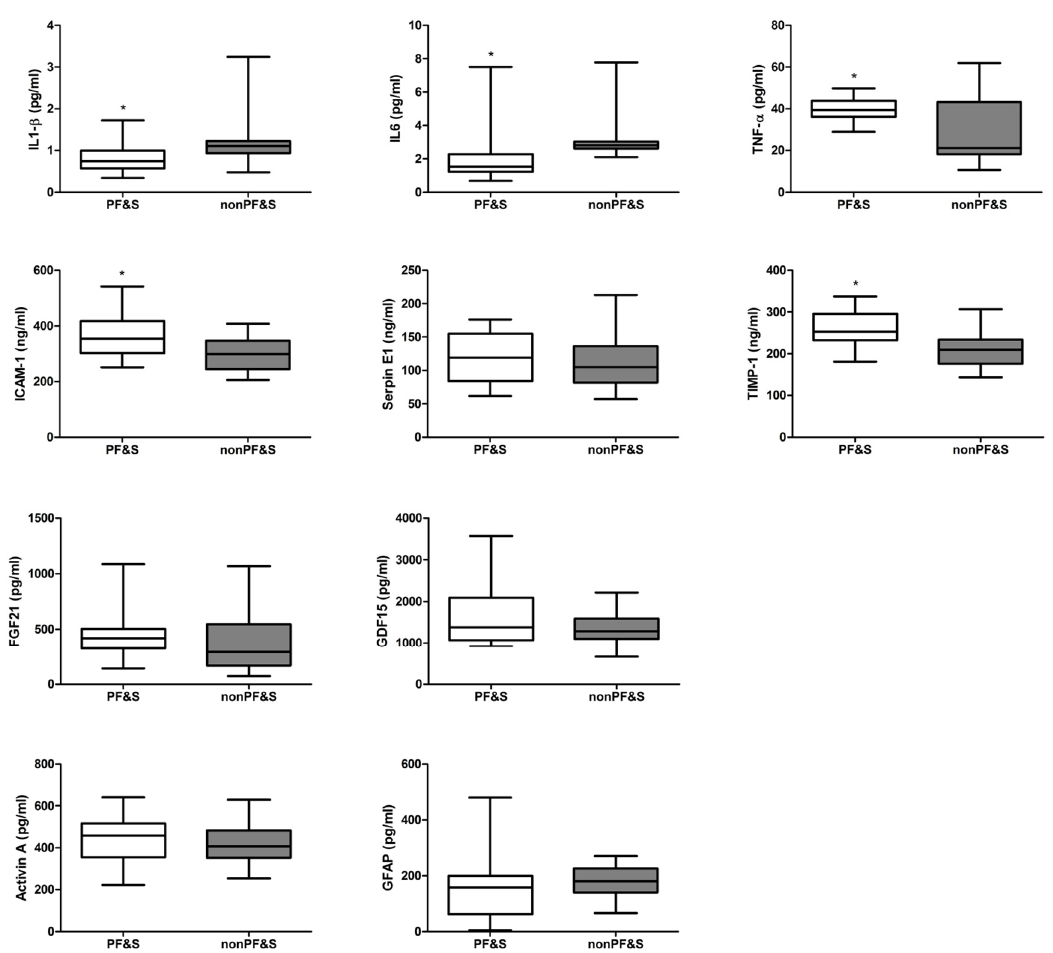
Figure 1. Serum Concentrations of Inflammatory, Mitochondrial, and Senescence-Related Markers in Participants with and without Physical Frailty and Sarcopenia (PF&S). Box plots show the median serum concentration (bold horizontal line), interquartile range (box), and total range of concentrations (whiskers) of markers. Abbreviations: FGF21, fibroblast growth factor 21; GDF15, growth/differentiation factor 15; GFAP, glial fibrillary acidic protein; ICAM-1, intercellular adhesion molecule 1; IL, interleukin; nonPF&S, non-physically frail, non-sarcopenic; TIMP-1, tissue inhibitor matrix metalloproteinase 1; TNF- α , tumor necrosis factor- α ; * p <